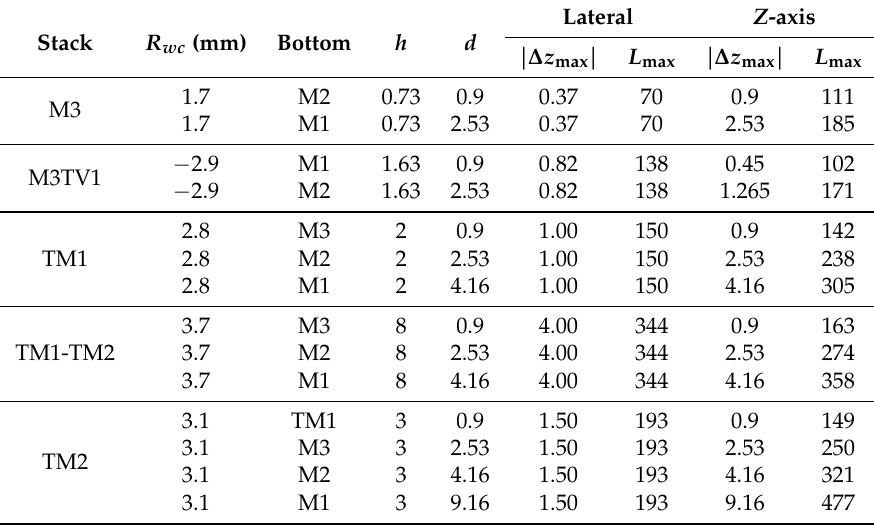
Table 7. Estimated maximum device size L max for selected layer configurations. The values without specified unit are in